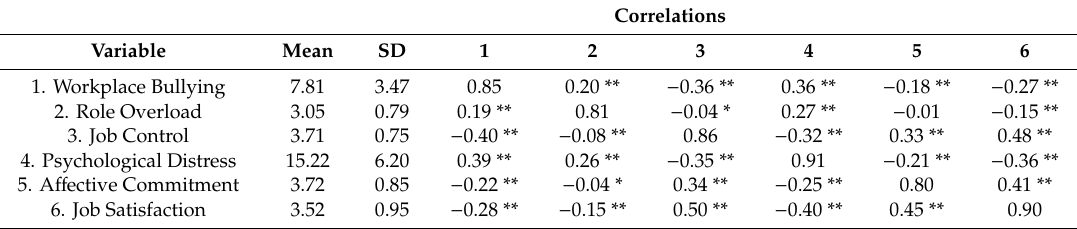
Table 1. Descriptives, reliabilities and correlations among study